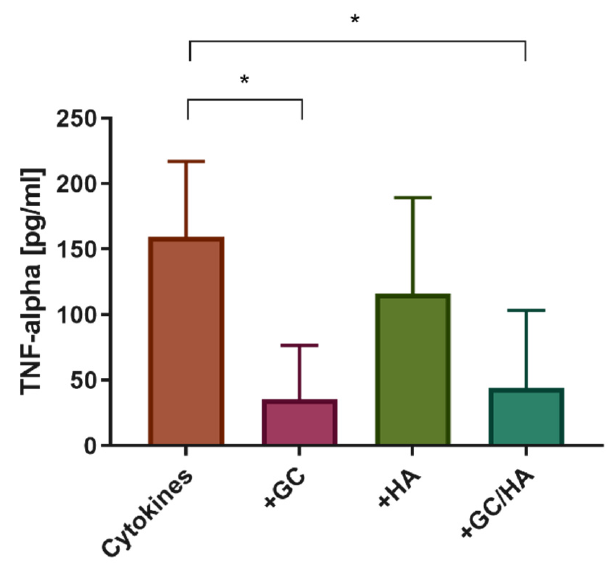
Figure 7. Measurement of TNF- α in the supernatant of treated chondrocytes. The single asterisk indicates p < 0.05.